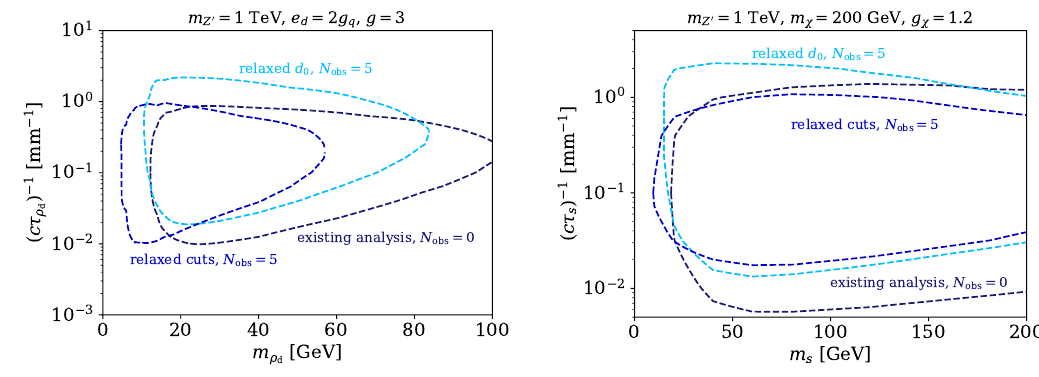
Figure 9 . Projected exclusion contours for 300 fb − 1 for the dark shower model (left) and the dark Higgs model (right) under the assumption that each of the modified analyses leads to 5 observed events, while the original analysis remains background-free. Note that we conservatively assume that no background subtraction is performed (see text for